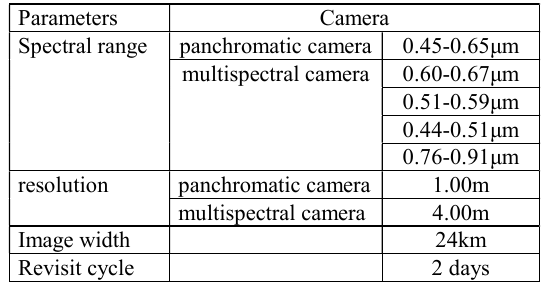
Table 3. The image in this study used IW imaging mode.